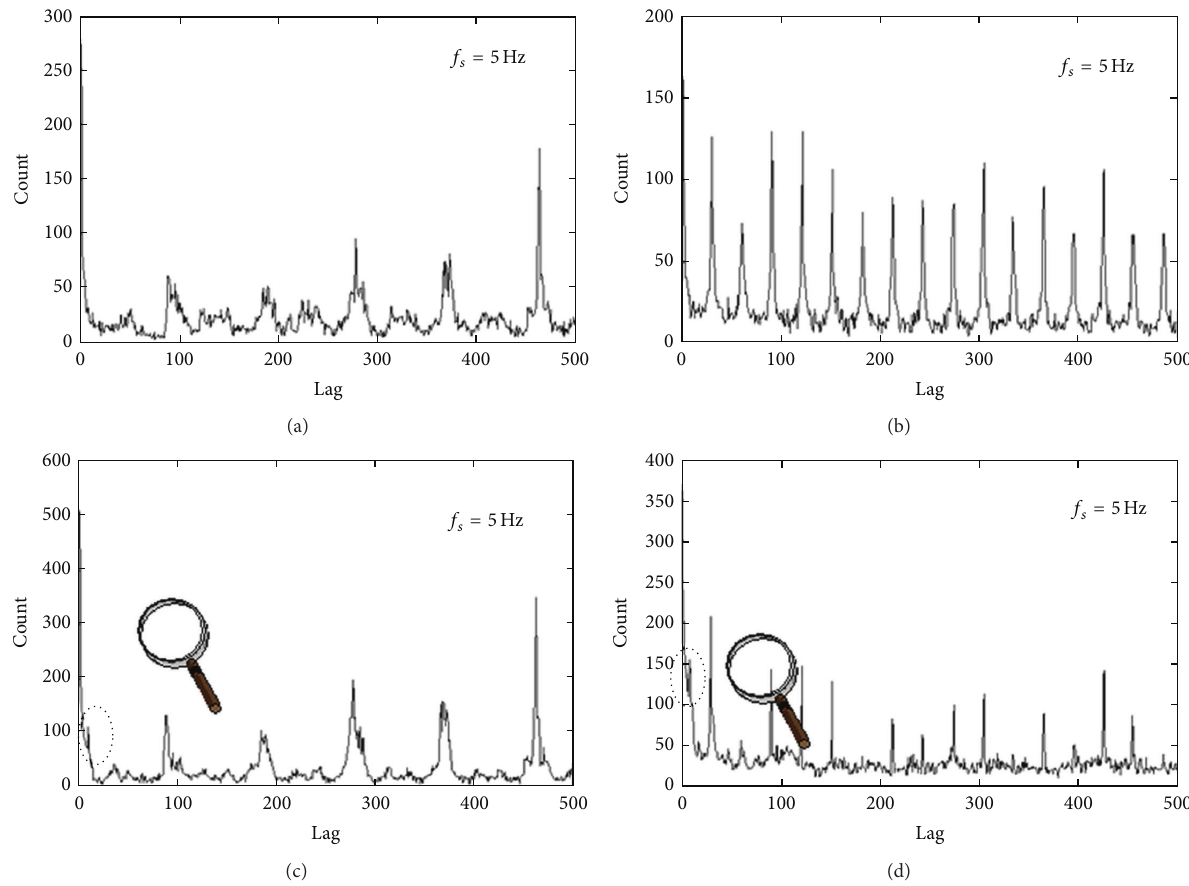
Figure 6: Time delay histograms for (a) Lorenz 𝑋𝐿 -coordinate; (b) Rossler 𝑋𝑅 -coordinate; (c) Lorenz magnitude 𝐴 𝑋𝐿 vector; (d) Rossler magnitude 𝐴 𝑋𝑅 vector. Note the additional peaks provided by 𝐴(𝑡) (dotted circles) and how the periodicities are